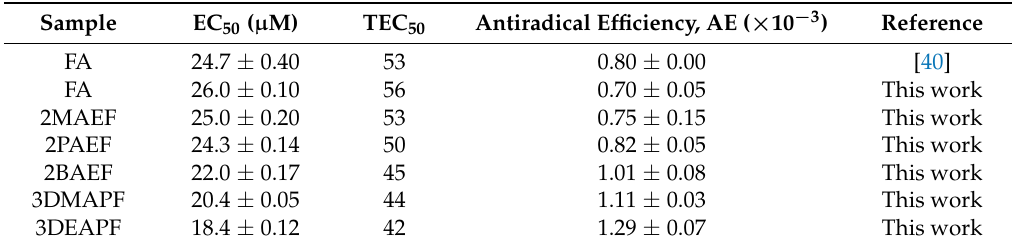
Table 1. Parameters of radical scavenging activity of parent acid (FA) and synthesized PILs: EC 50 ( µ